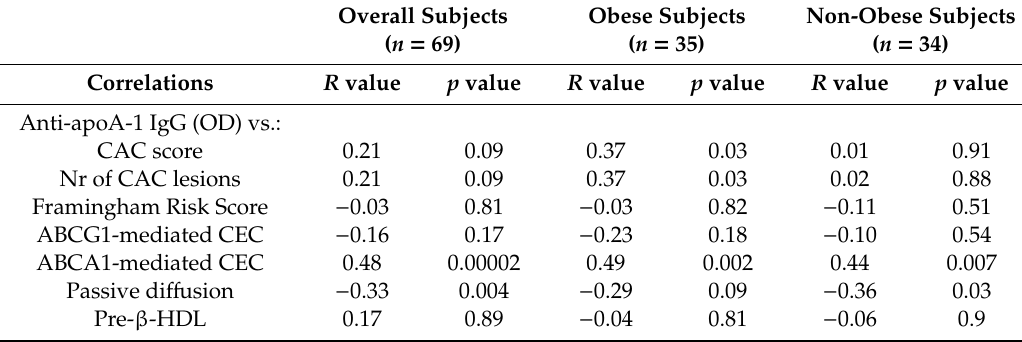
Table 4. Spearman’s correlations between anti-apoA-1 IgGs, Specific CEC Pathways, Pre- β -HDL, and hsCRP